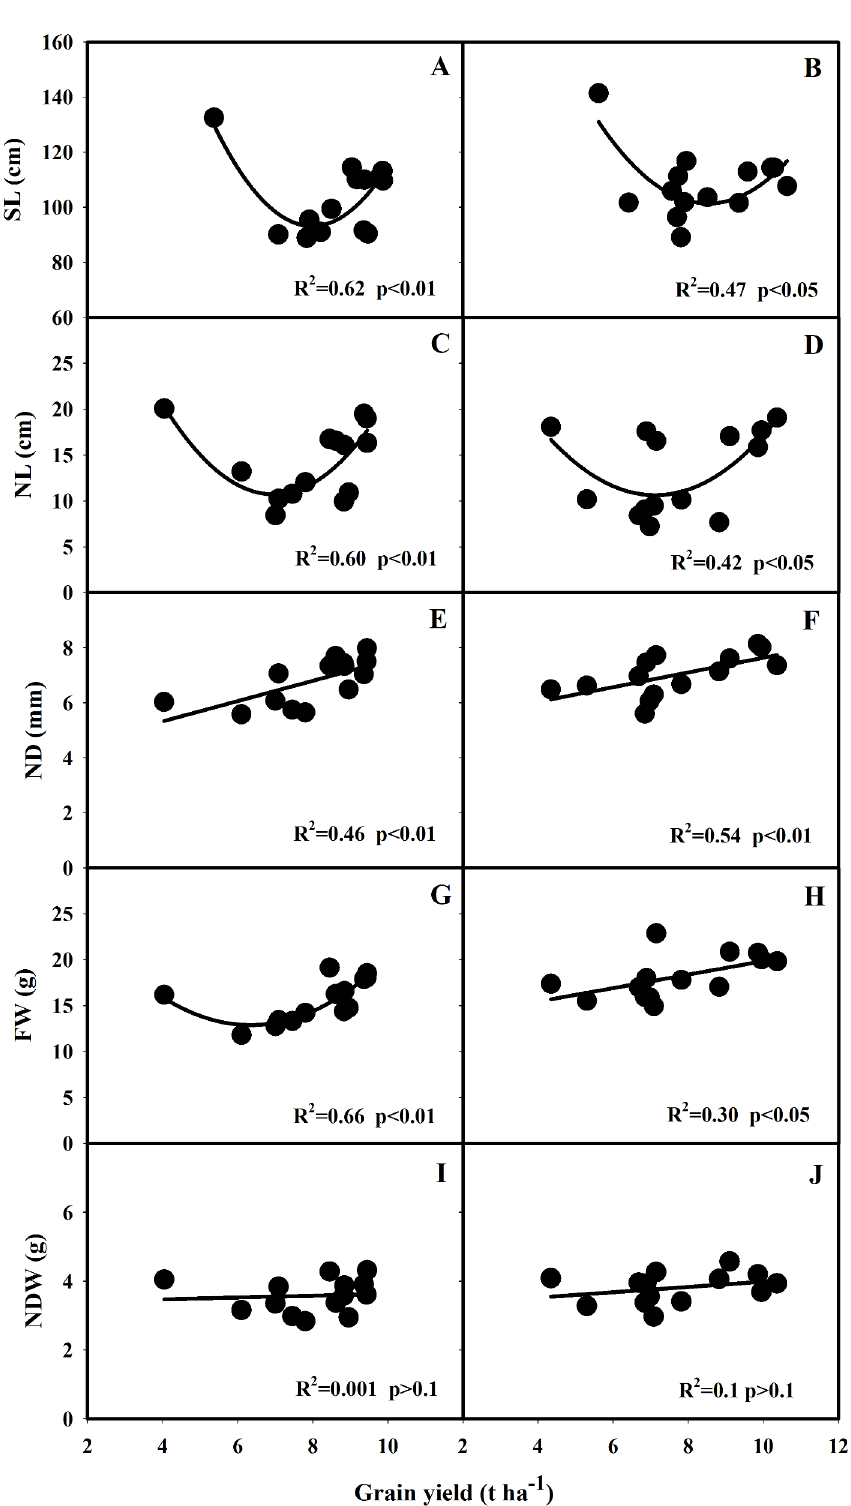
Fig 4. The correlation between grain yield and SL (A, B), NL (C, D), ND (E, F), FW (G, H) and NDW (I, J) of the rice varieties grown in 2013 and 2014. SL: stem length from the base of N 3 internode to the tip of the panicle, NL: N 3 internode length, ND: N 3 internode diameter, FW: stem fresh weight, NDW: N 3 internode dry weight.